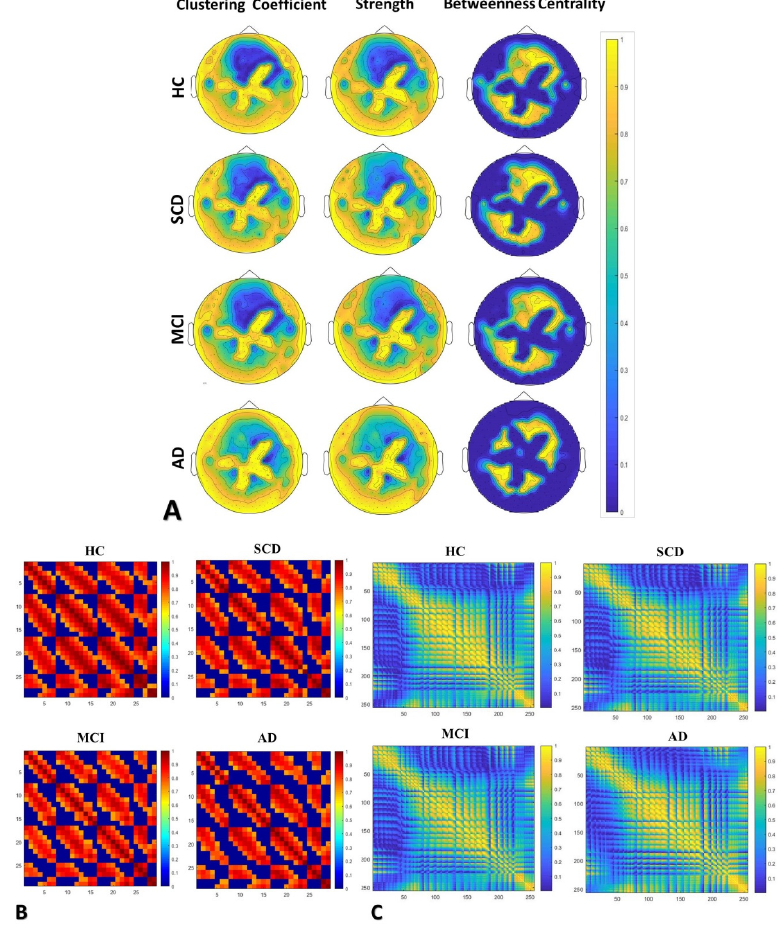
Figure 2. ( A ) Topo plots for the three network metrics (clustering coefficient, strength and betweenness centrality), ( B ) correlation matrices of local networks (29 parietal electrodes) and ( C ) correlation matrices of global networks (256 electrodes) across the four groups of participants (HC = 22, SCD = 20, MCI = 30, AD = 20).